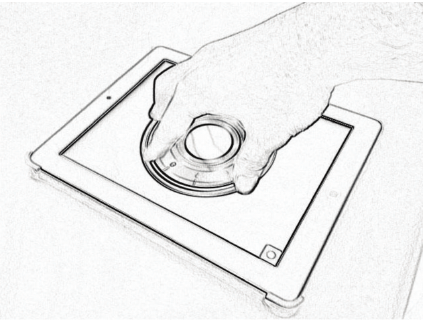
Figure 1: An example of